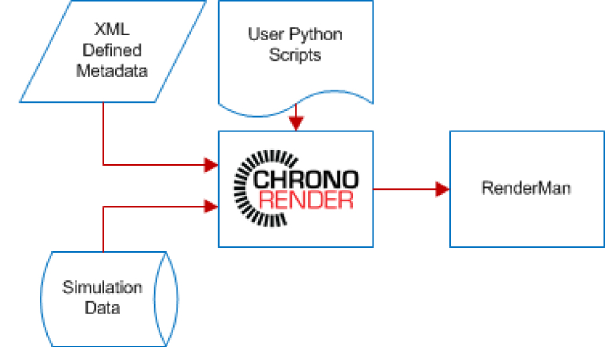
Figure 21. Chrono ::Render architecture.